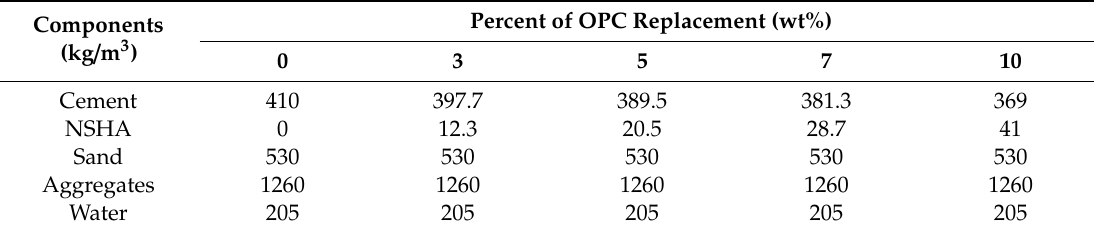
Table 2. Concrete mix